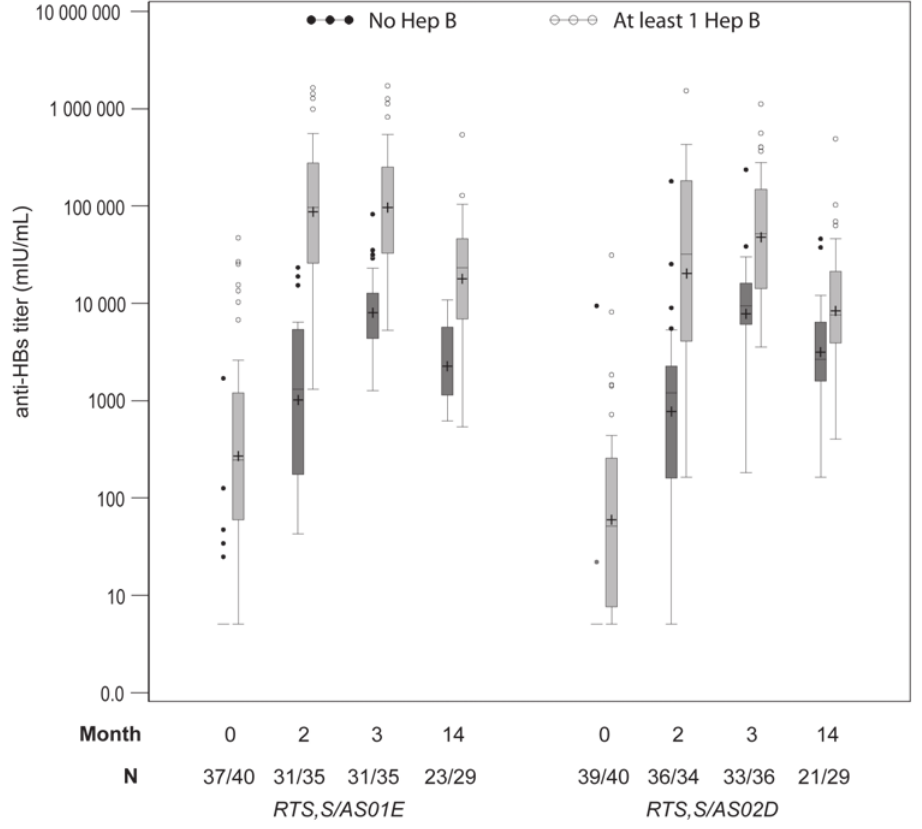
Figure 3. The effect of previous hepatitis B vaccination on anti-HBs antibodies. Boxplot graph of anti-HBs responses. Represents Q25, median, Q75, highest and lowest observation below/above 1.5 times interquartile range and individual data points below/above 1.5 times interquartile range. GMTs are indicated by + . three timepoints for either vaccine. Post Dose 3, GMTs for recipients of RTS,S/AS01 E were 94879 mIU/mL and 7982 mIU/ mL and for recipients of RTS,S/AS02 D were 48279 mIU/mL and 8292 mIU/mL with previous hepatitis B vaccination and without previous hepatitis B vaccination, respectively (Table 4).